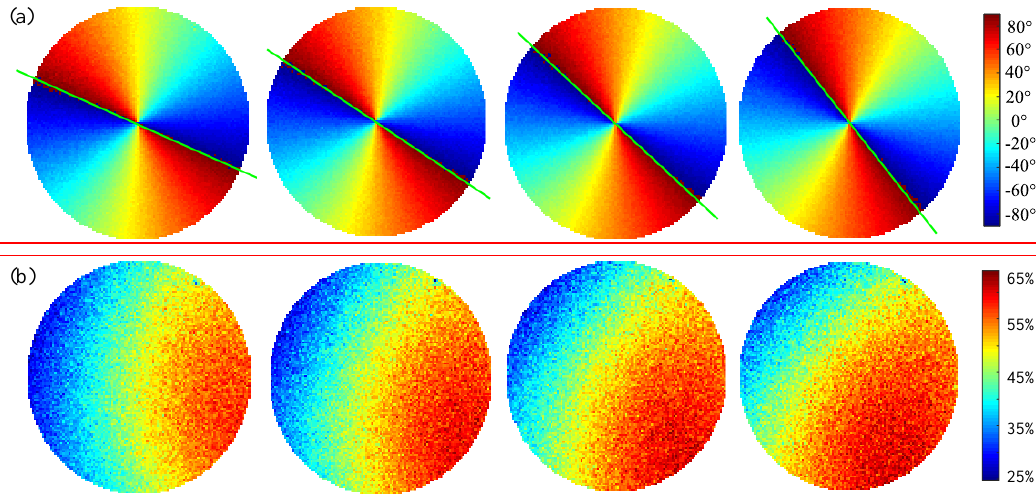
Figure 9. Skylight polarization patterns at four adjacent positions. ( a ) angle of polarization; ( b ) degree of